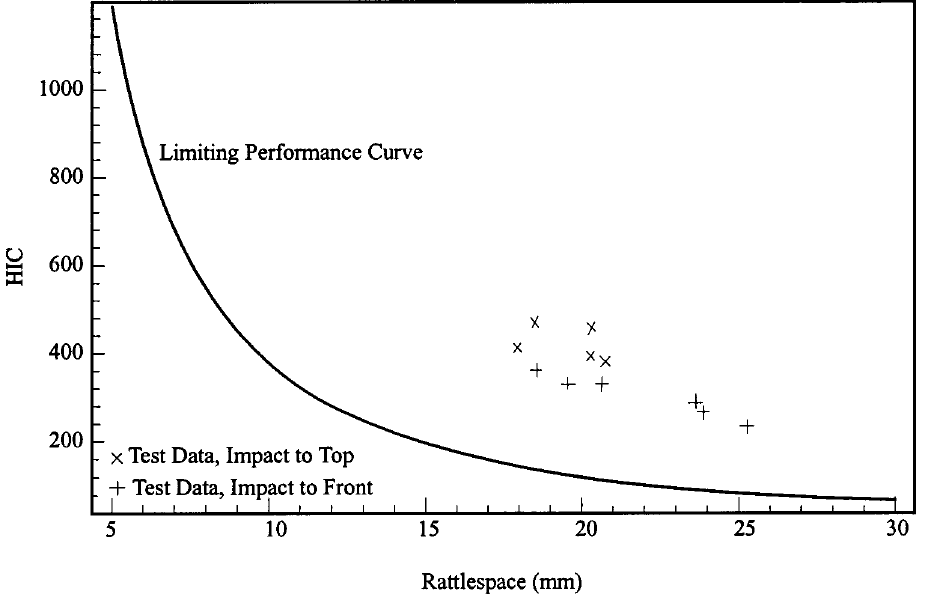
Fig. 6. Performance of bicycle helmets in tests based on HIC.